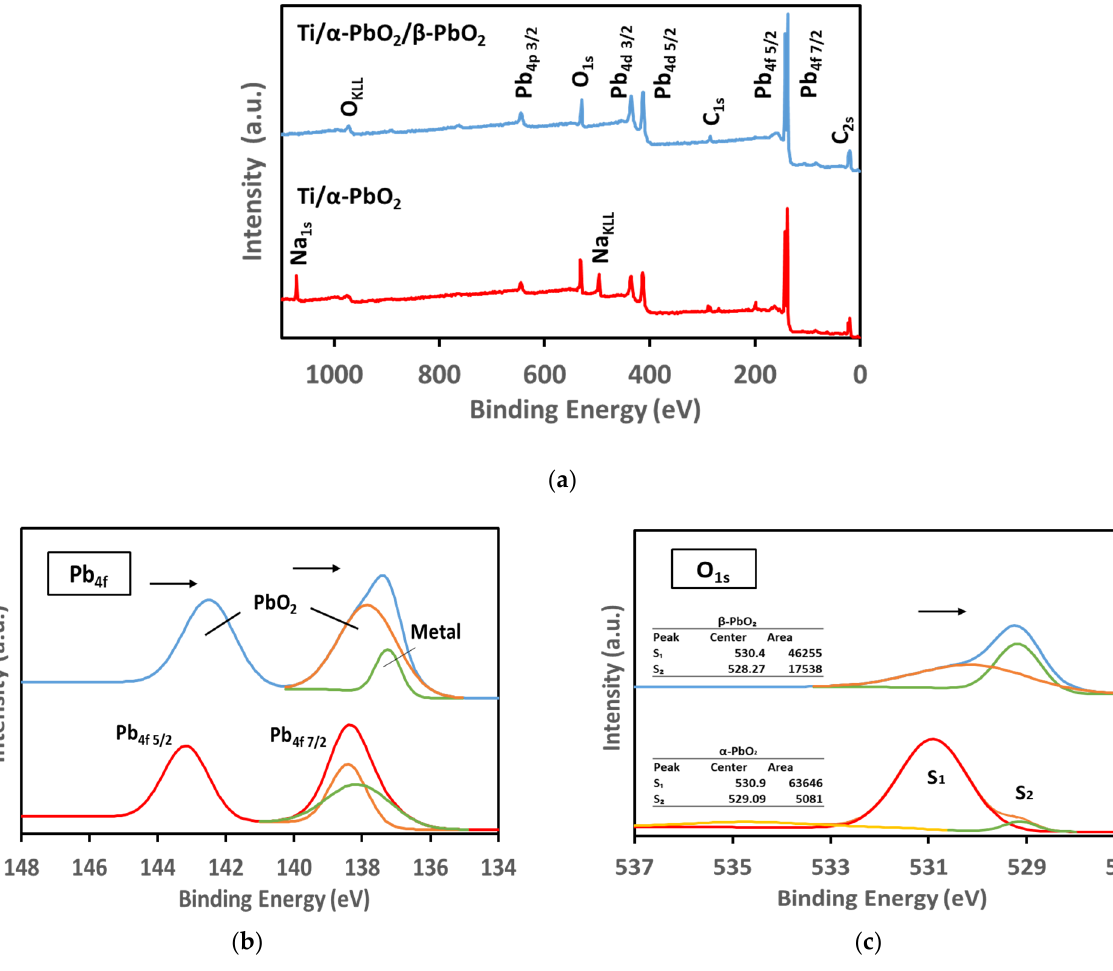
Figure 3. ( a ) XPS analysis of Ti/α-PbO 2 /β-PbO 2 and Ti/α-PbO 2 ; ( b ) Pb 4f spectra of Ti/α-PbO 2 /β-PbO 2 and Ti/α-PbO 2 ; ( c ) O 1s spectra of Ti/α-PbO 2 /β-PbO 2 and Ti/α-PbO 2 .